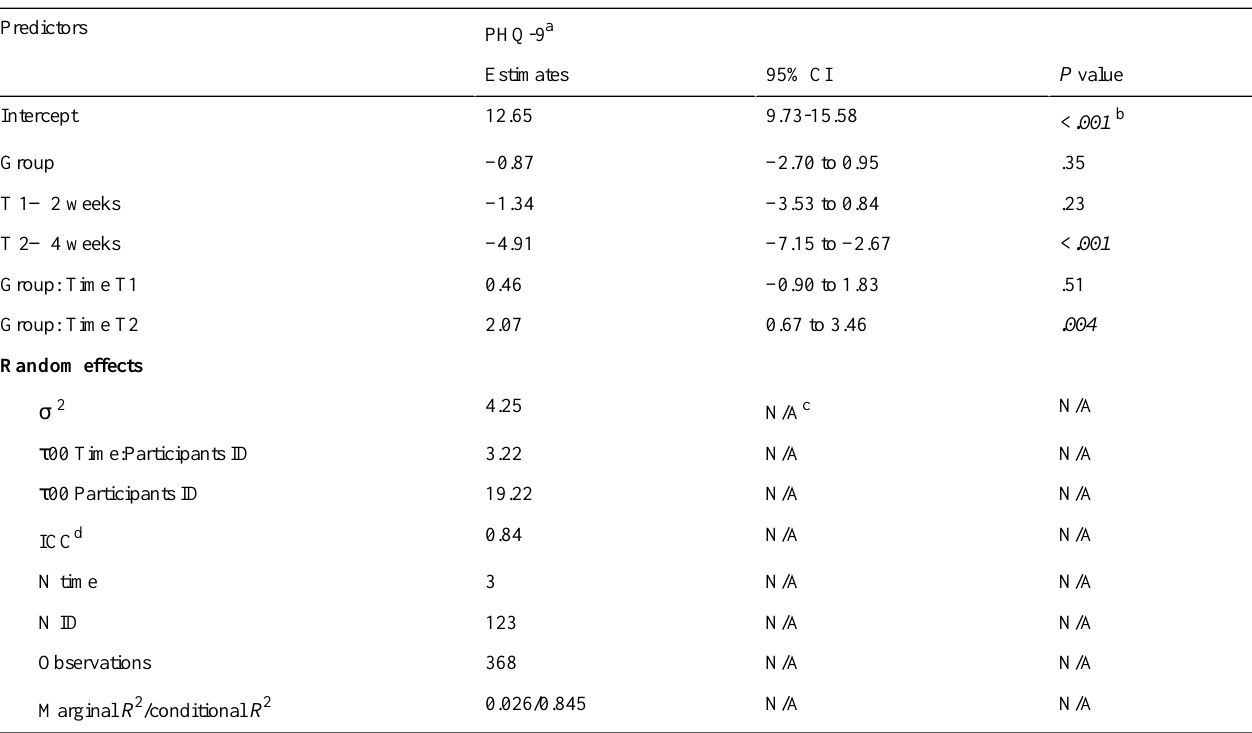
Table 6. Summary of the linear mixed model on Patient Health Questionnaire scores over the duration of the intervention (T0, T1, and T2) in the intervention and waitlist control groups.